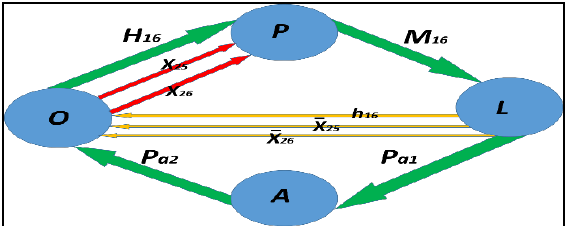
Figure 5. Automatic graph of the M